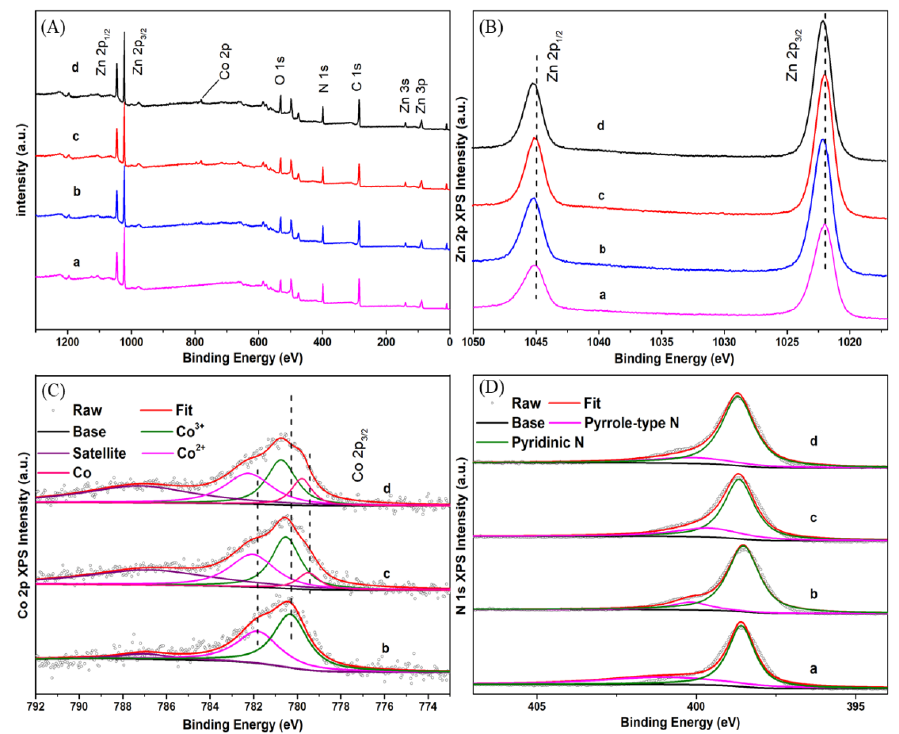
Figure 2. XPS spectra of (a) ZnO/NC-600, (b) ZnCo 0.8 /NC-600, (c) ZnCo/NC-600 and (d) ZnCo 1.2 /NC-600: ( A ) full range XPS spectra; ( B ) Zn 2p spectra; ( C ) Co 2p spectra; ( D ) N 1s spectra.